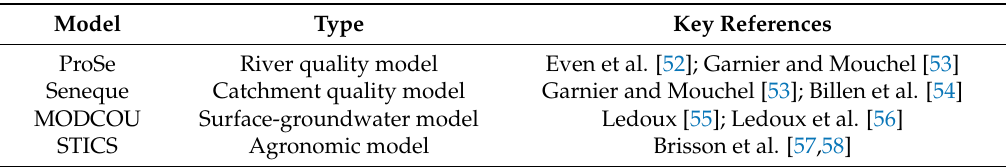
Table 2. Overview of PIREN-Seine Support Tools